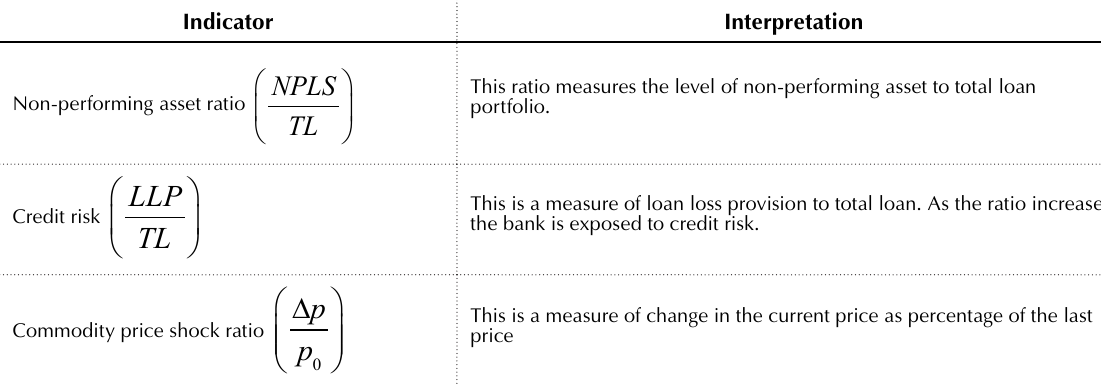
Table 6. Measures of credit risk ratio